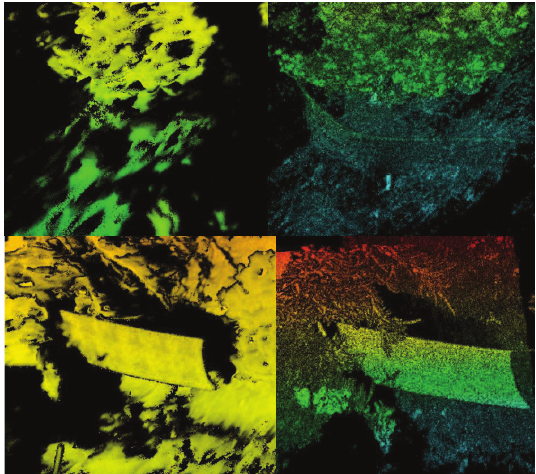
Figure 7: Point clouds of Targets 3 (top) and 4 (bottom), VZ-400 and HRS-3D point clouds are on the left and right sides, respec-